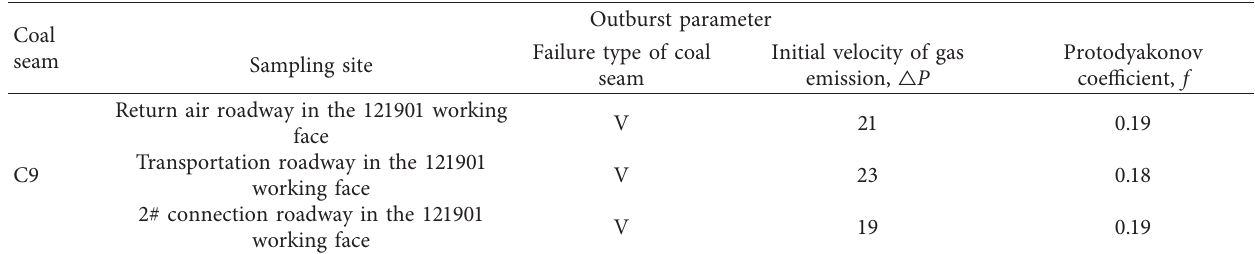
Table 3: Failure type in the C9 coal seam, initial velocity of gas emission, and firmness coefficient.